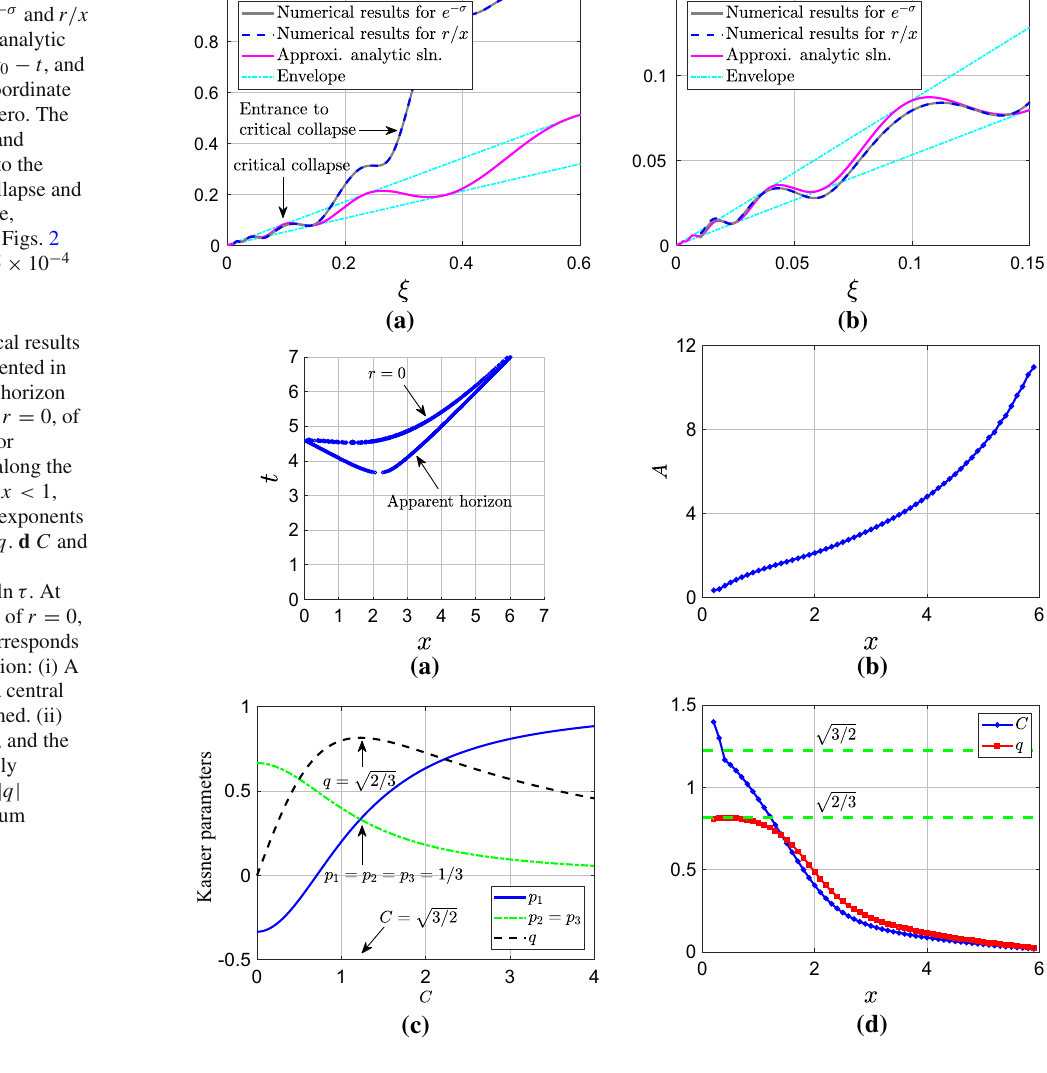
Fig. 7 Some numerical